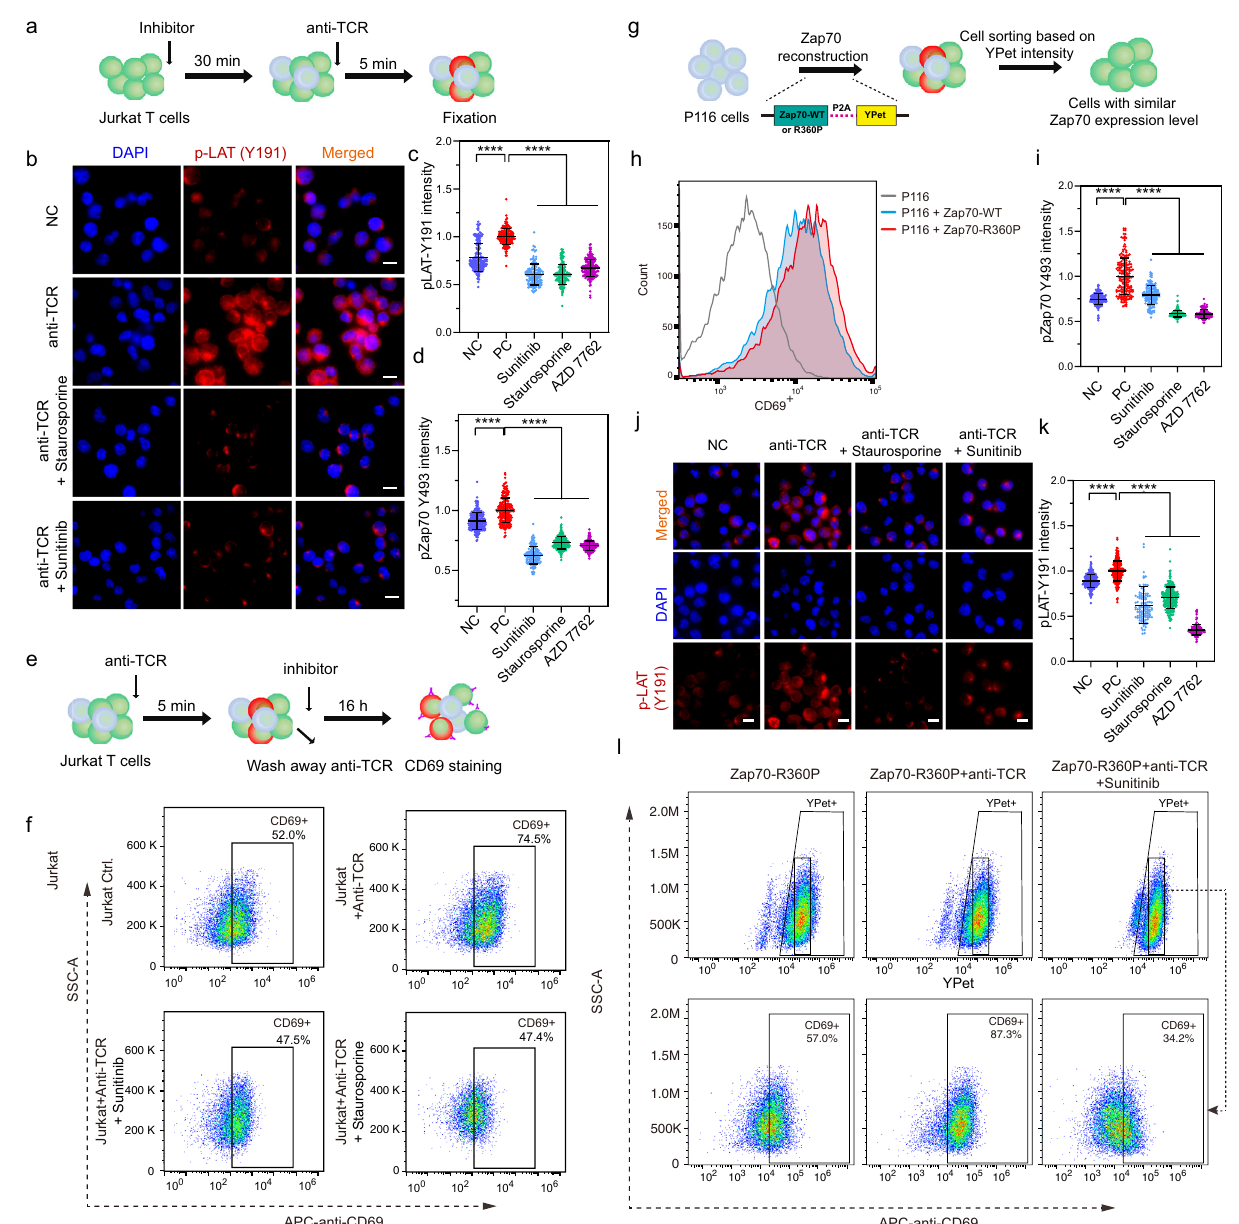
Fig. 7 Inhibition of T cell activation by the HTDS-identi fi ed ZAP70 inhibitors. a Experimental scheme and timeline for experiments in ( b – d ). Jurkat T cells were pre-treated with inhibitors for 30 min before anti-TCR stimulation by anti-CD3/CD28 antibodies for 5 min. b Immunostaining images of pLAT (Y191) in Jurkat T cells with different inhibitor pre-treatments. Scale bars, 10 µ m. c Quanti fi cation of pLAT (Y191) intensity of single cells in different groups. (From left to right, n = 197, 182, 139, 169, 213, respectively, One-way ANOVA, **** P < 0.0001). NC represents Jurkat T cells without any treatment, PC represents Jurkat T cells stimulated with anti-TCR only. Data were normalized to the PC group. Error bars, mean ± SD. d Quanti fi cation of Phosphorylated ZAP70 (Y493) intensity of single cells in different groups. (From left to right, n = 249, 222, 136, 276, and 230, respectively, One-way ANOVA, **** P < 0.0001). Error bars, mean ± SD. e Experimental scheme, and timeline for CD69 staining experiment. f Flow-cytometry analysis of CD69 expression in T cells after anti-TCR stimulation, with or without inhibitors pre-treatment. Each biological replicate had similar results ( n = 3). g Experimental scheme, and timeline of P116 cells reconstituted with ZAP70. Full-length ZAP70-WT or R360P were expressed with YPet via a cleavable P2A linker. P116 cells with similar ZAP70- WT or ZAP70-R360P expressions were sorted and isolated for further analysis based on YPet intensity. h CD69 expression in P116 cells with or without the expression of ZAP70 (WT) and its mutant (R360P). i Quanti fi cation of pZAP70 (Y493) intensity of P116-ZAP70 R360P cells with different inhibitor pre-treatments. (From left to right, n = 202, 191, 150, 280, 110, respectively, One-way ANOVA, **** P < 0.0001). Error bars, mean ± SD. j Images of pLAT (Y191) in P116-ZAP70 R360P cells with different inhibitor pre-treatments. Scale bars, 10 µ m. k Quanti fi cation of pLAT (Y191) intensity of P116-ZAP70 R360P cells with different inhibitor pre-treatments. (From left to right, n = 275, 252, 116, 240, 190, respectively, One-way ANOVA, **** P < 0.0001). Error bars, mean ± SD. l Flow-cytometry analysis of CD69 expression in P116 – ZAP70-R360P cells after anti-TCR stimulation, with or without sunitinib pre- treatment. ZAP70-R360P expression levels in P116 cells were indicated by YPet intensity. Source data including the gating strategies are provided as a Source Data fi